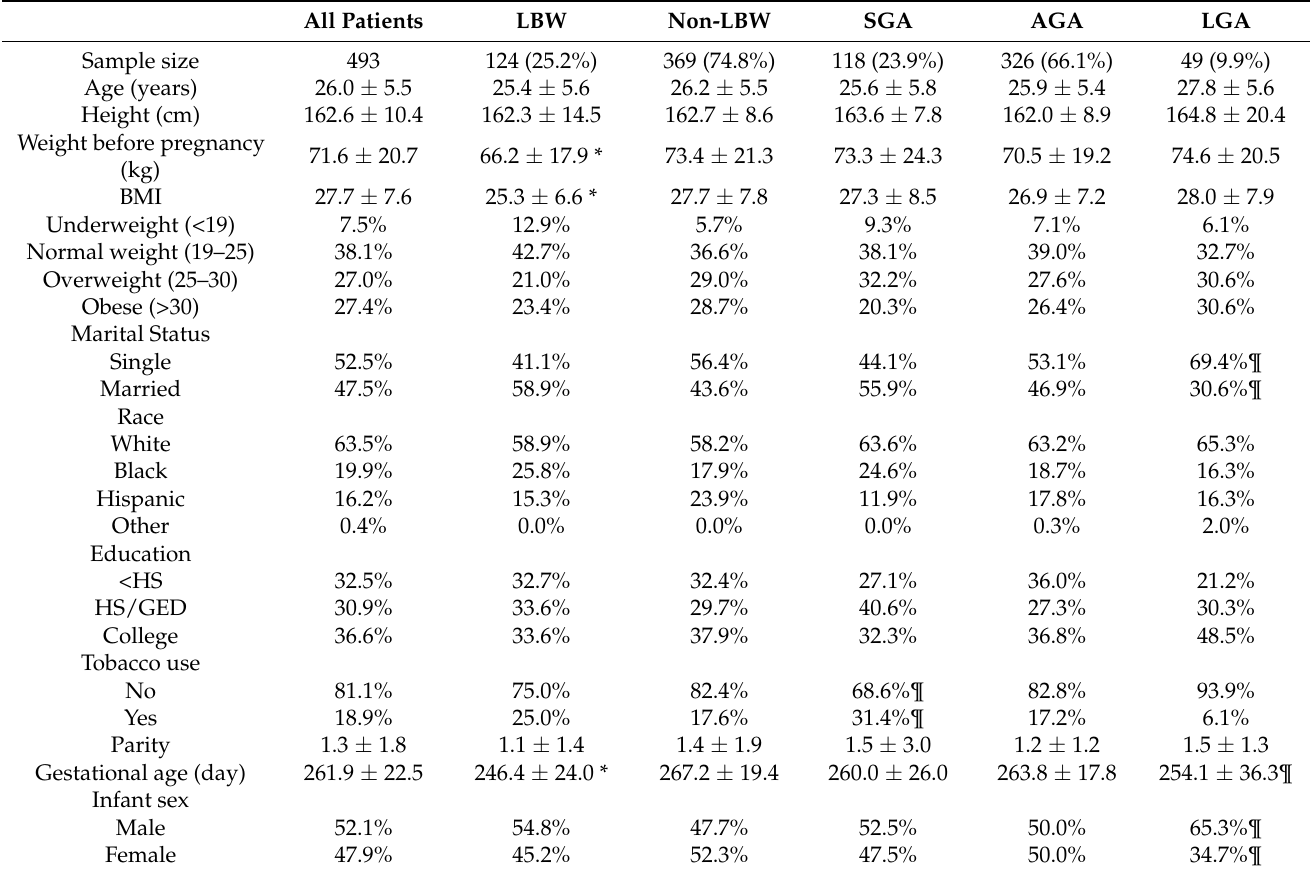
Table 1. Population characteristics of the cohort profiled in the present untargeted metabolome investigation. * Indicates a significant difference from Non-LBW. ¶ indicates a significant difference from AGA. Abbreviations. BMI: Body mass index, HS/GED: High school/General Educational